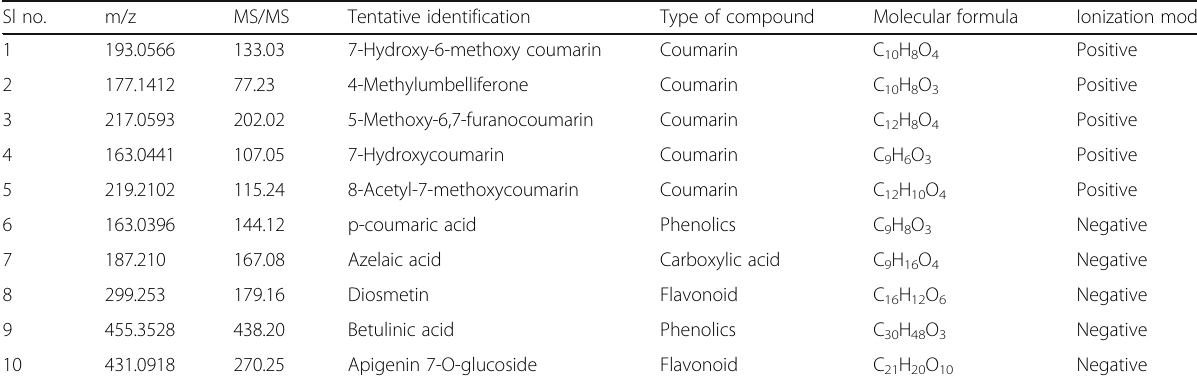
Table 2 APCI – LC-MS/MS analysis of GTK